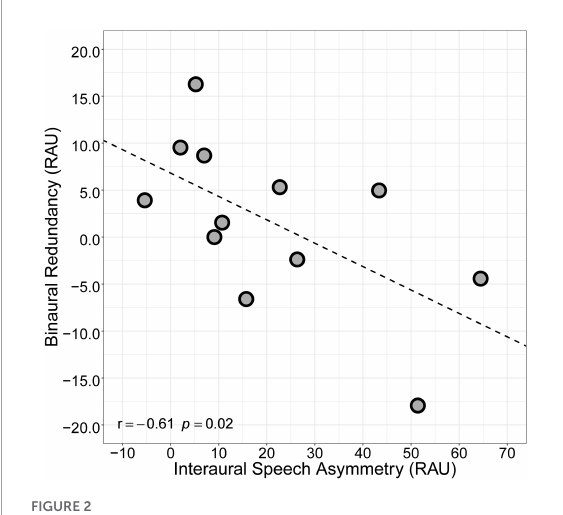
FIGURE2 Relationship between interaural speech asymmetry (RAU) and binaural redundancy, defined as the difference in speech intelligibility (RAU) between Bilateral and Better Ear conditions.